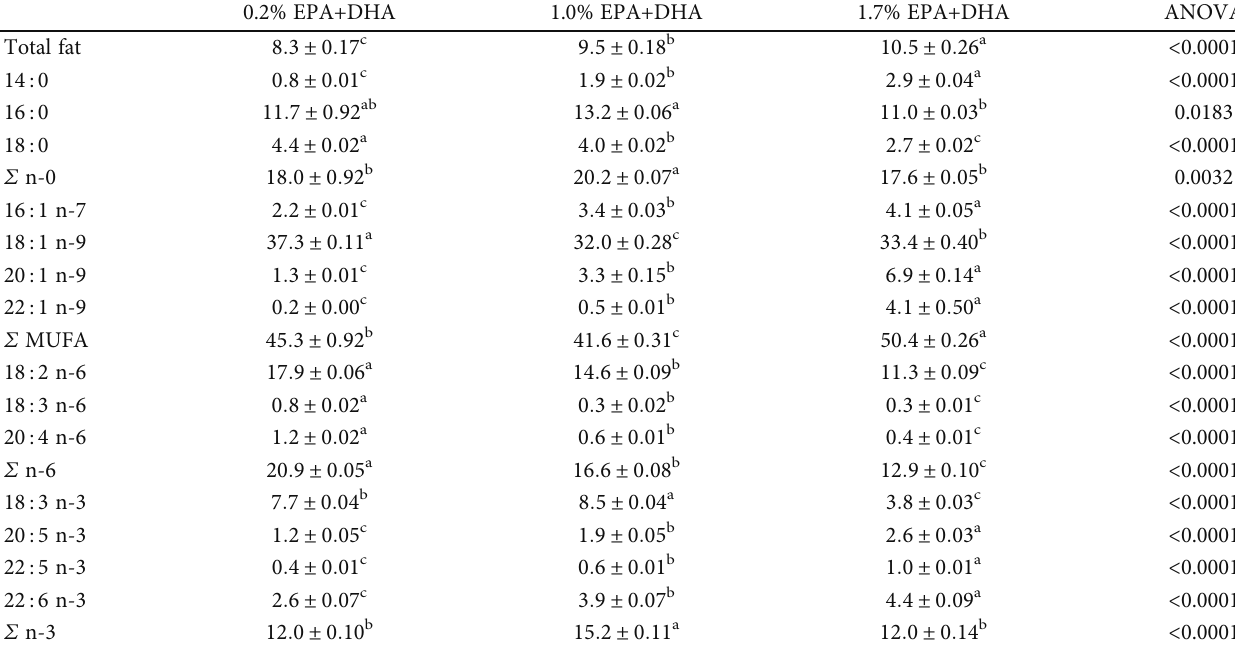
Table 3: Fatty acid composition (% of total) in the muscle of Atlantic salmon (1200g) fed the experimental diets from 400g. Data are shown as mean ± SEM ( n = 24 , being each sample represented by a pool of 2 fi sh).